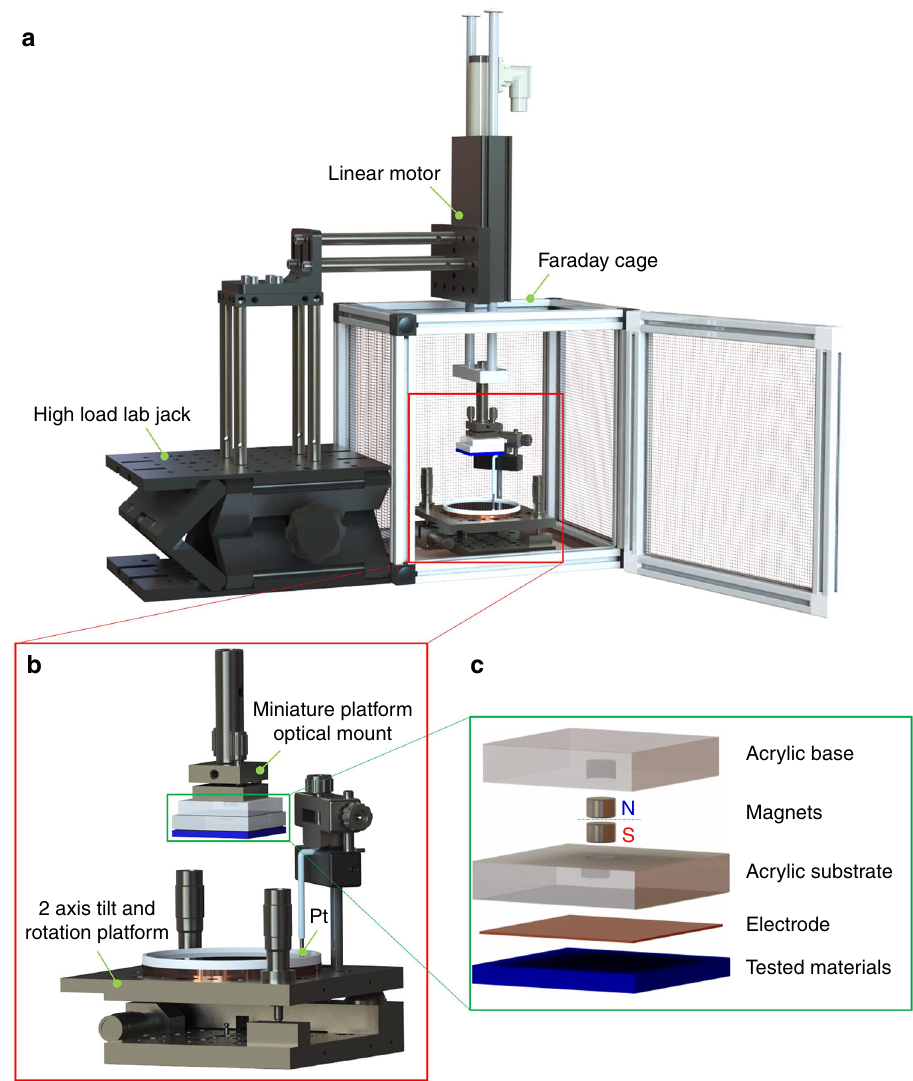
Fig. 2 Experimental set-up for the triboelectric series measurement. The whole measurement was set in a glove box fi lled with ultra-high purity of nitrogen gas at fi xed temperature, pressure, and humidity. The linear motor was settled on a high-load lab jack ( a ). The height of the sample to contact the liquid metal can be fi nely adjusted by both the high-load lab jack and a linear motor. The static part has the liquid metal as the electrode. The motion part consists of the tested sample, and it is controlled by the linear motor ( b ). An acrylic base is attached to the end of the linear motor. A magnet is engraved into the acrylic base to attract another magnet engraved in the sample substrate. Each sample consists of an acrylic substrate with the magnet, electrode, and the tested materials ( c ). Both the miniature platform optical mount and the two-axis tilt and rotation platform can adjust the orientations of the sample